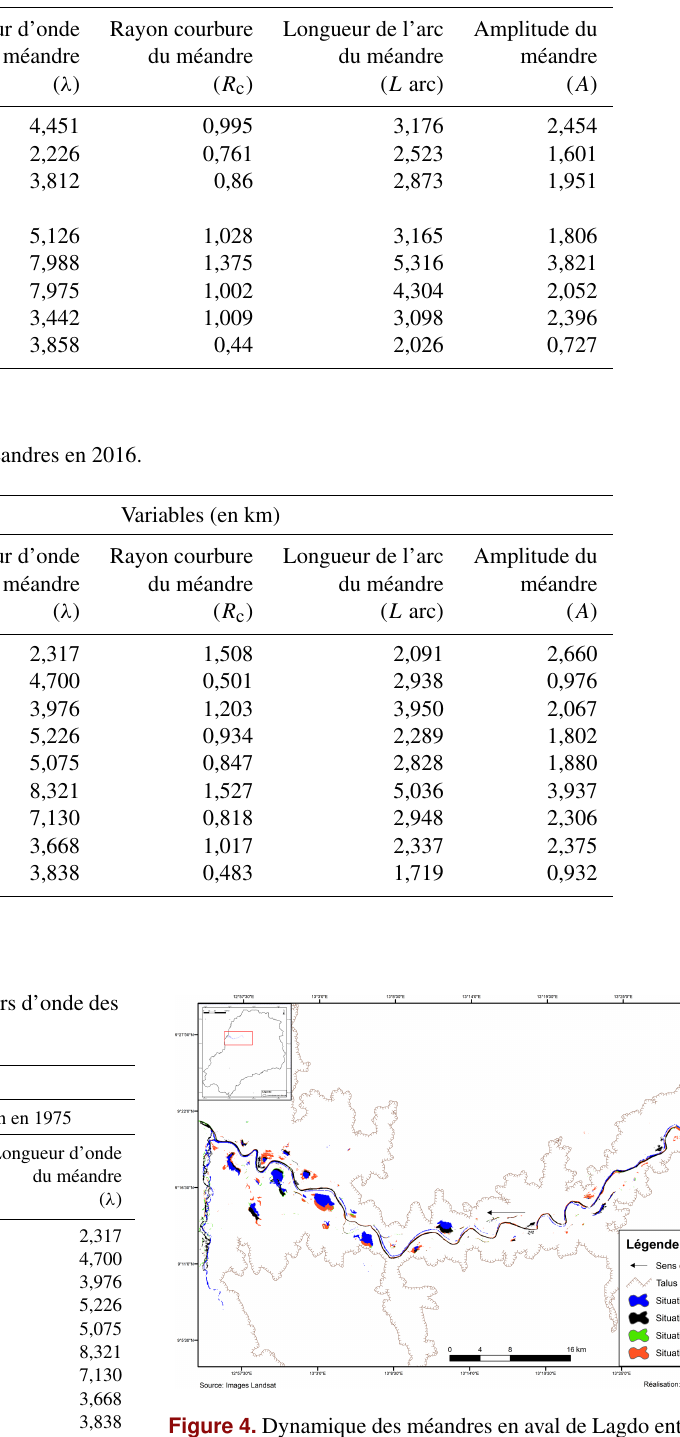
Figure 4. Dynamique des méandres en aval de Lagdo entre 1975 et